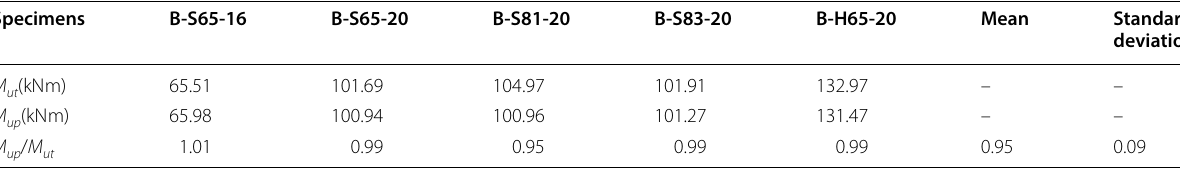
Table 8 Comparison of test and predicted ultimate